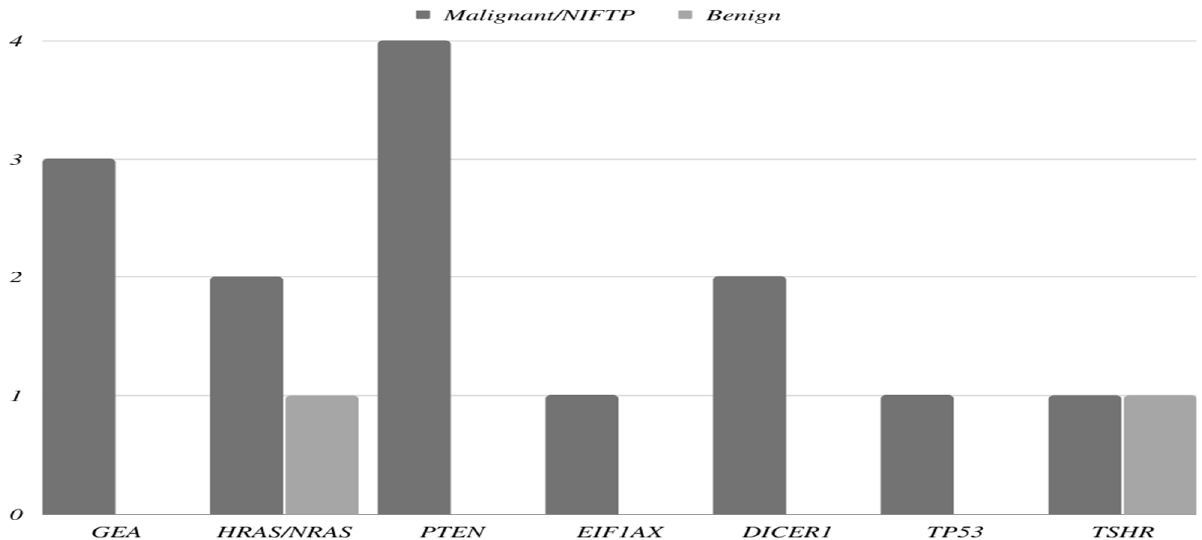
Figure 1. Prevalence of an additional molecular alteration based on tumor type.